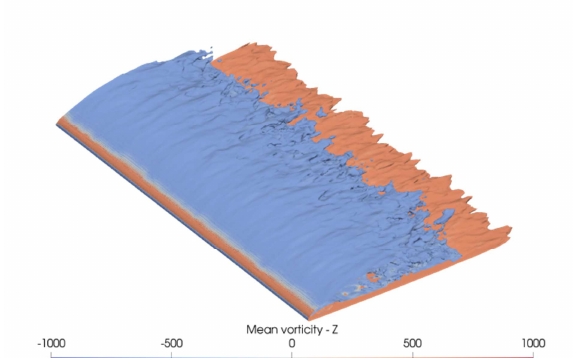
Fig. 16 . Iso-surface of mean vorticity 500 1/s . Coloured by its spanwise oriented